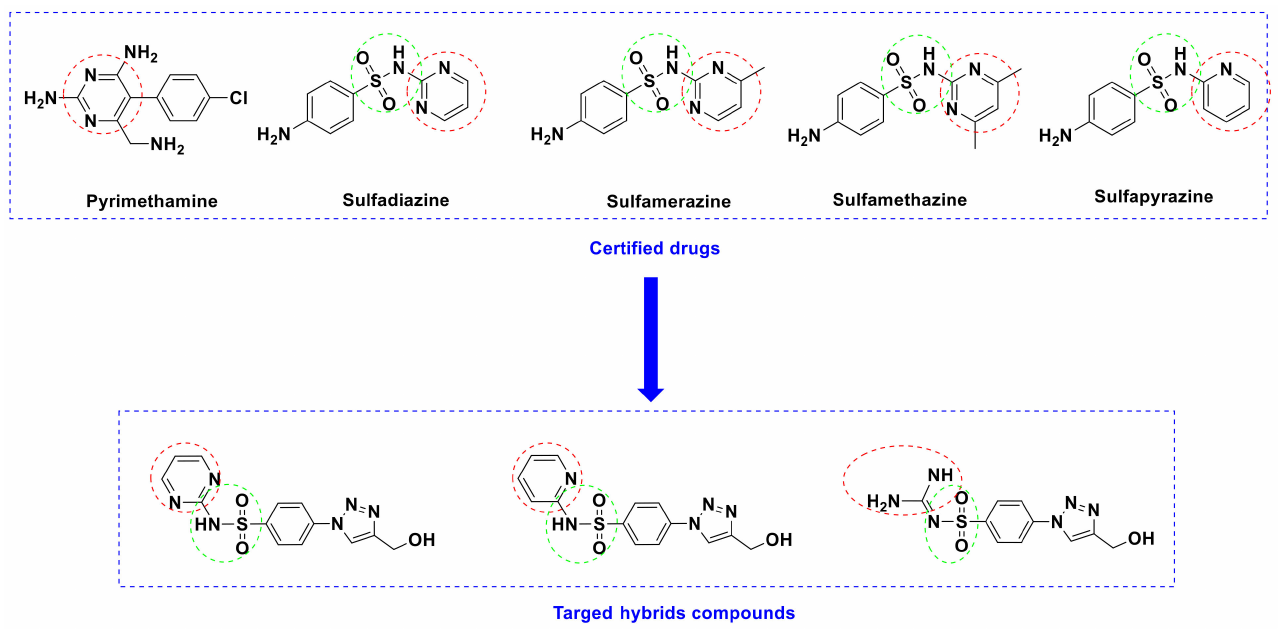
Figure 1. Schematic representation of the rational